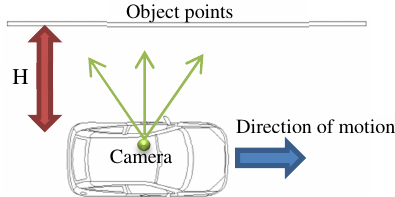
Figure 2. Schema of the simulation (H = object-to-camera distance)